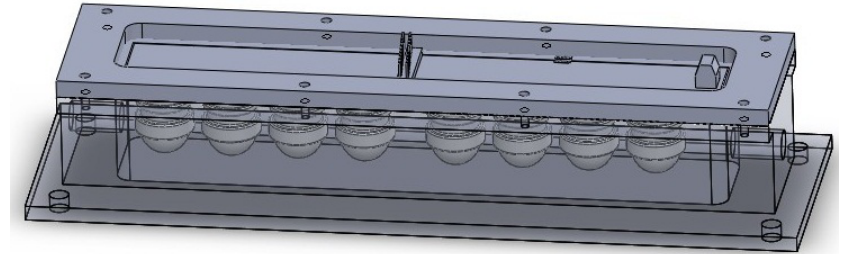
Figure 2. Schematic diagram of the PTFE